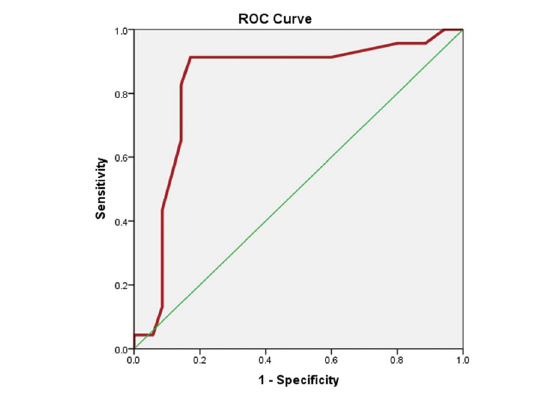
Figure 4: Receiver-operator characteristics (ROC) curve for serum albumin to predict the formation of multiple band ulcers. The best cut off value of albumin from the ROC co-ordinates of the curve was 2.85 mg/dl with a sensitivity of 91.3% and specificity of 83.0% for the prediction of multiple